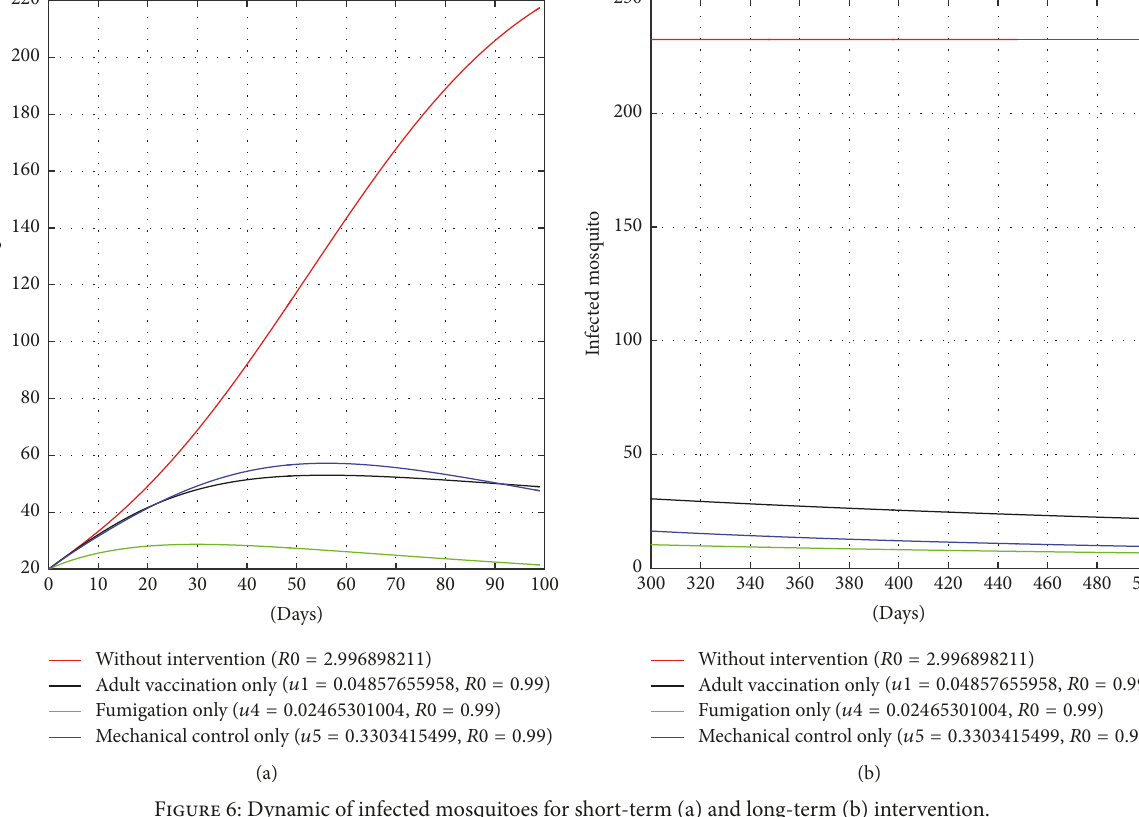
Figure 6: Dynamic of infected mosquitoes for short-term (a) and long-term (b)